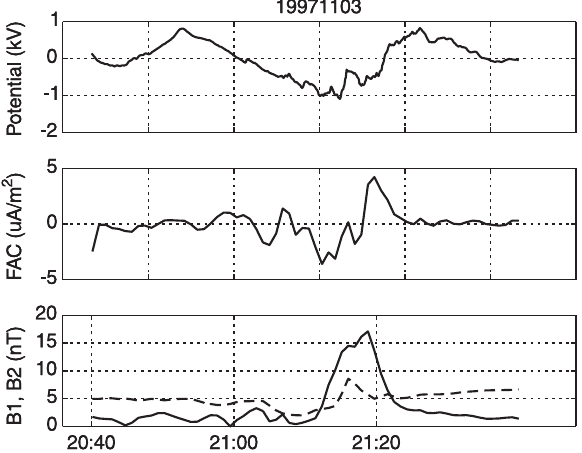
Fig. 6. Event 971103 21:05–21:25 UT. B FAC estimate is rather reliable. The potential and the FAC have the same sign so this event could support the upward extended U-shaped potential picture, but the magnitude of the potential ( (cid:24) 1 kV) is small. Among our 78 events only two are somehow compatible with the upward extended U-shaped potential picture, and this is one of them